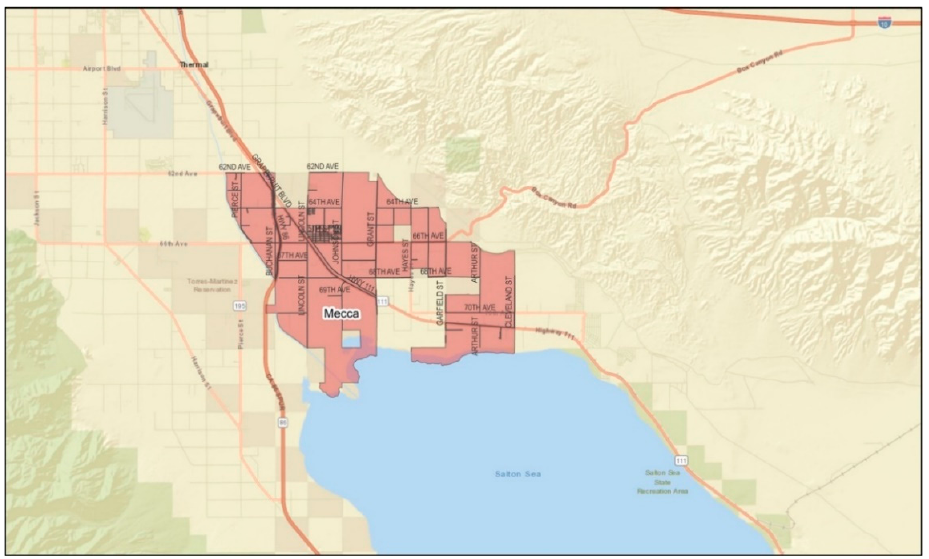
Figure 1. Geographical division of the community of Mecca. (Source: Riverside University Health System—Public Health).